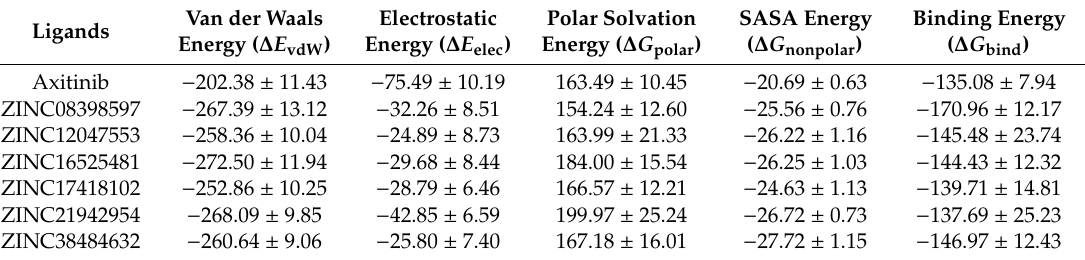
The predicted binding free energy and the individual energy components (kJ / mol) ligand-VEGFR2